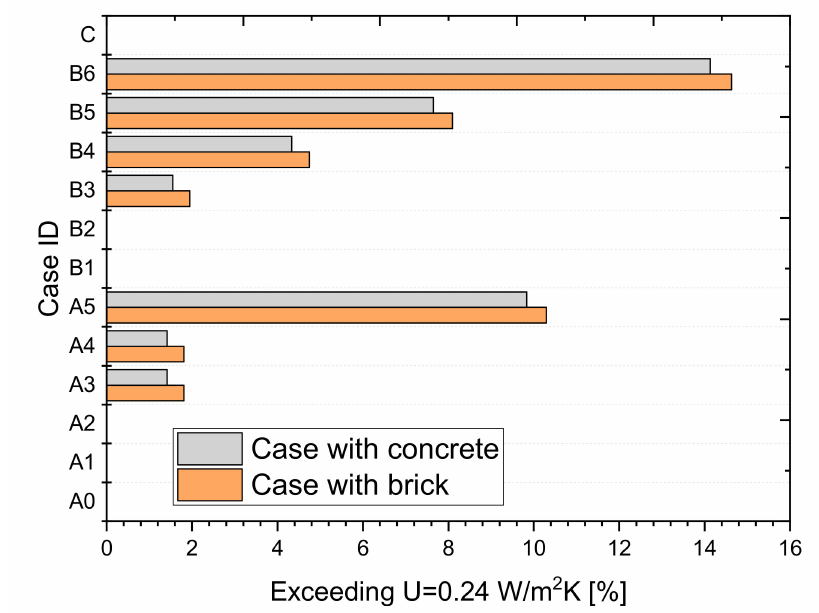
Figure 6. The percentile changes in the U-value, compared with U = 0.24 W / m 2